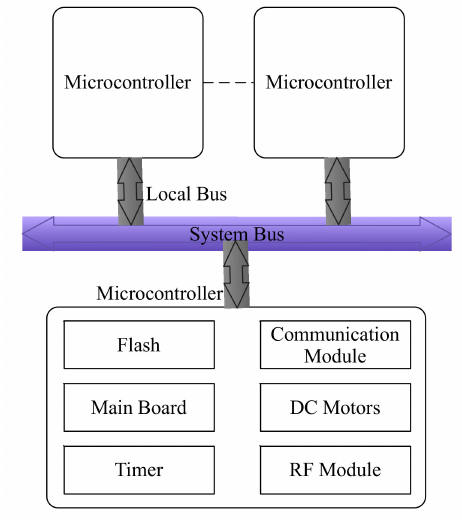
Figure 2. The smart microcontroller